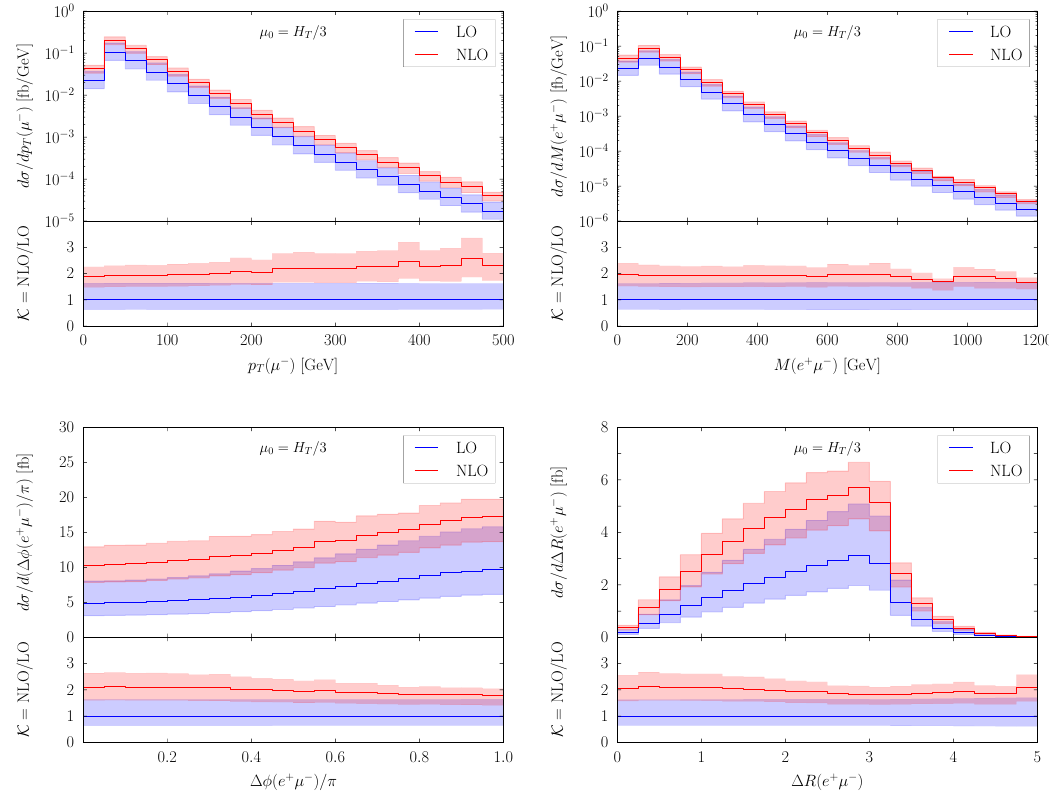
Figure 8 . As in figure 5 but for the p T ( µ − ) , M ( e + µ − ) , ∆ φ ( e + µ − ) and ∆ R ( e + µ − ) distributions. on the overall theoretical uncertainty for differential cross section distributions for the pp → e + ν µ − ¯ ν b ¯ b b ¯ b + X process. For all observables that we have examined we could e µ confirm that the PDF uncertainties are small and well below the theoretical uncertainties predicted by scale variation. As an example in figure 9 we present NLO differential cross section distributions as a function of the transverse momentum of the 1 st , 2 nd , 3 rd and 4 th hardest b -jet. Upper panels show the absolute NLO predictions for three different PDF sets as obtained with the dynamical scale setting. Middle panels display the relative scale uncertainties of NLO predictions for the NNPDF3.1 PDF set. Also presented are the relative predictions for the MMHT2014 and CT18NLO PDF set. They are obtained by normalisation to the central NLO prediction with the NNPDF3.1 PDF set. Finally, lower panels display the relative internal PDF uncertainties of the NLO cross section for each of the three PDF sets. Also here all NLO predictions are normalised to the central NLO prediction with the NNPDF3.1 PDF set. A few comments are in order. To start with, at the differential level the internal PDF uncertainties are up to 11% for CT18NLO and of the order of 8% for MMHT2014. For the default NNPDF3.1 PDF set they are in the 1% − 7% range. When comparing the NLO QCD results as obtained with either CT18NLO or MMHT2014 to the findings generated for the default NNPDF3.1 PDF set the relative differences are up to 8% and 3% respectively. Thus, also at the differential level the